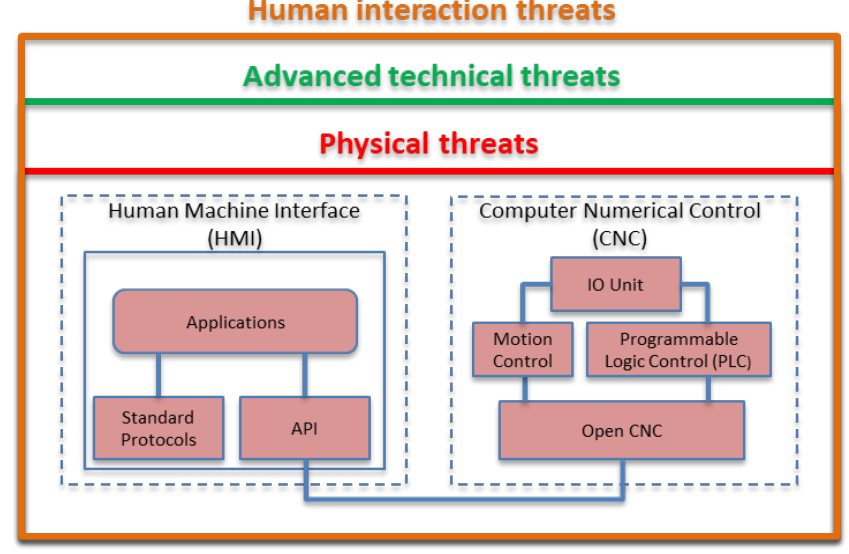
Figure 1. Abstract view of threats for legacy production machinery monitoring. API: application programming interfaces.